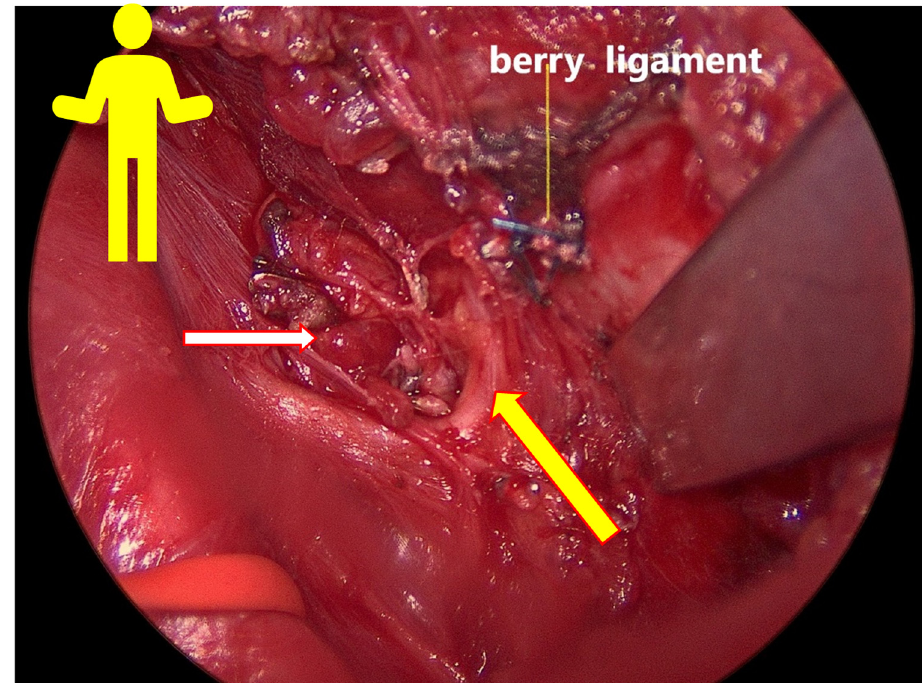
Figure 5. The yellow figure simulates the patient’s position on the OT table. The yellow arrow shows non-RLN type 2, and the white arrow shows the upper